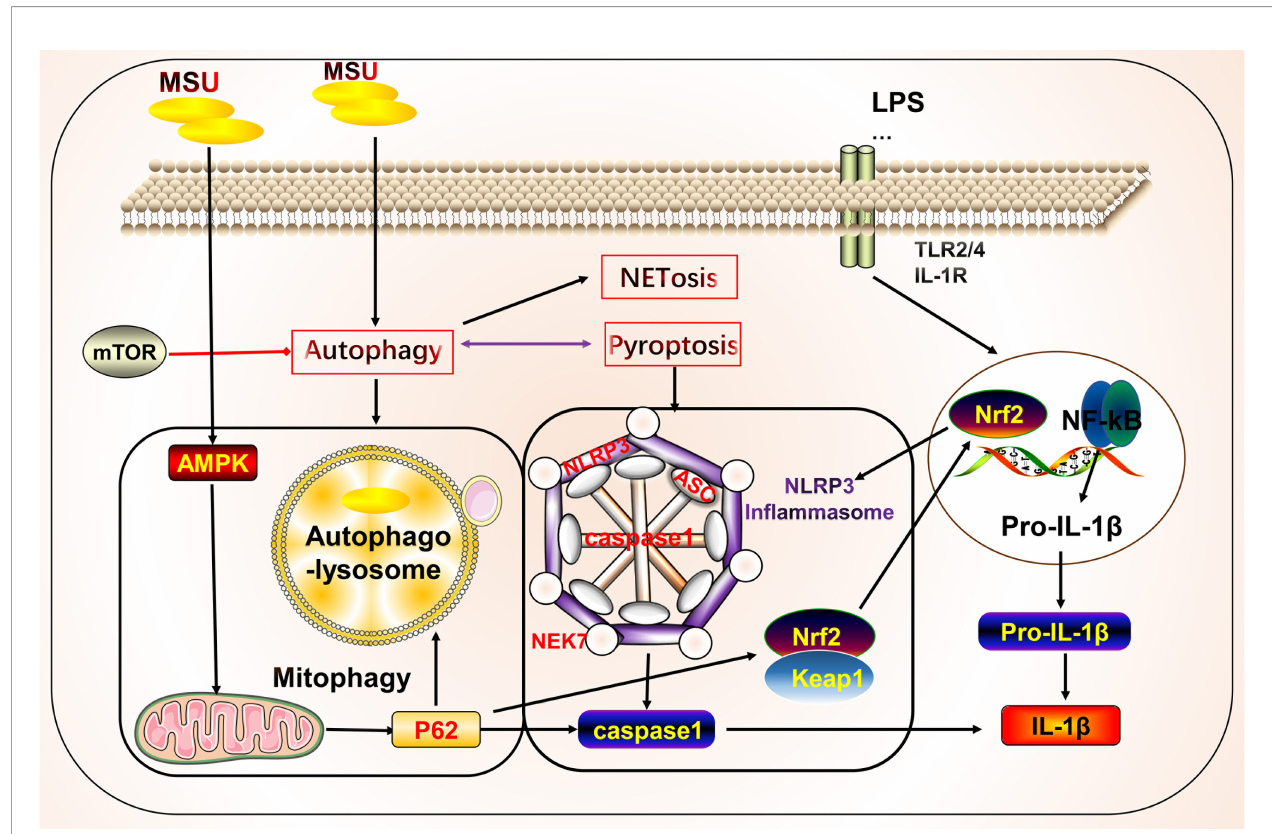
FIGURE 2 | Crosstalk between autophagy and pyroptosis on gout. Autophagy is primarily associated with pyroptosis in gout. Autophagy induced by monosodium urate (MSU) leads to the formation of autophagolysosomes that engulf MSU to isolate further in fl ammatory responses. AMPK is involved in autophagy regulation by regulating mitochondrial function. The autophagy protein P62 plays a dual role, participating in mitochondrial autophagy with anti-in fl ammatory effects and in crosstalk with pyroptosis to promote in fl ammation. Autophagy also cross-talks with other cell death pathways, such as